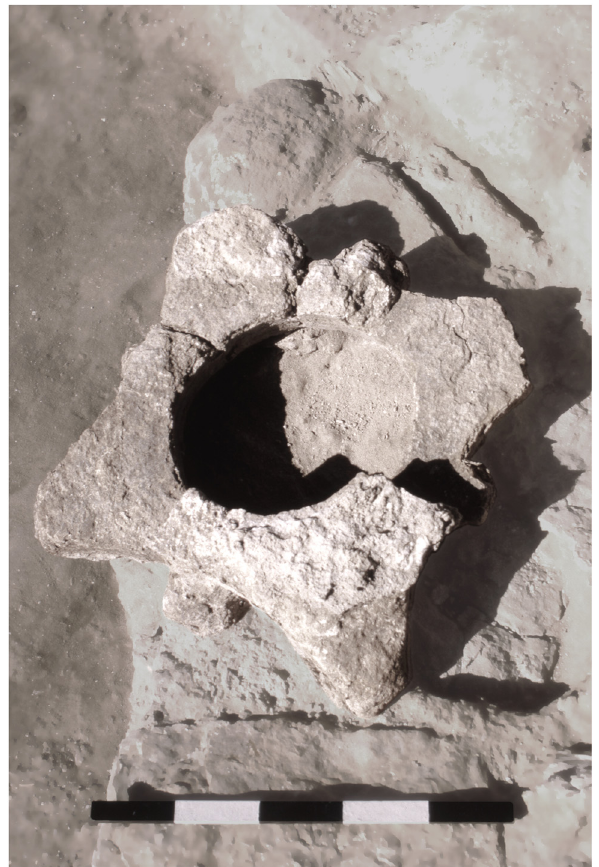
Figure 10: Blocked - out capital from Berenike trench BE95 - 4, scalebar measures 50.0 cm ( photography: S. E. Sidebotham )